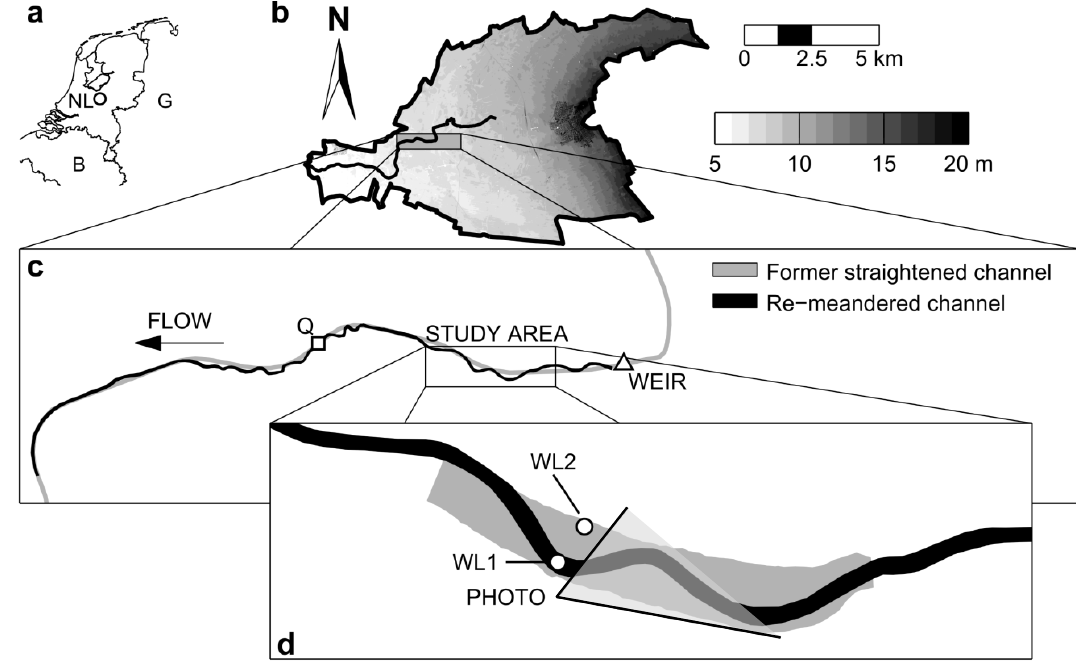
Figure 1. Overview of the study area: (a) location of the study area in the Netherlands; (b) elevation model of the catchment (Actueel Hoogtebestand Nederland, AHN; Van Heerd et al., 2000); (c) planform of the reconstructed reach, with the squared marker indicating the location of the discharge station ( Q ); and (d) sketch of the study area indicating the location of the water level gauges (WL1 and WL2) and the approximate extent of available terrestrial photographs (grey-shaded triangle, Fig.